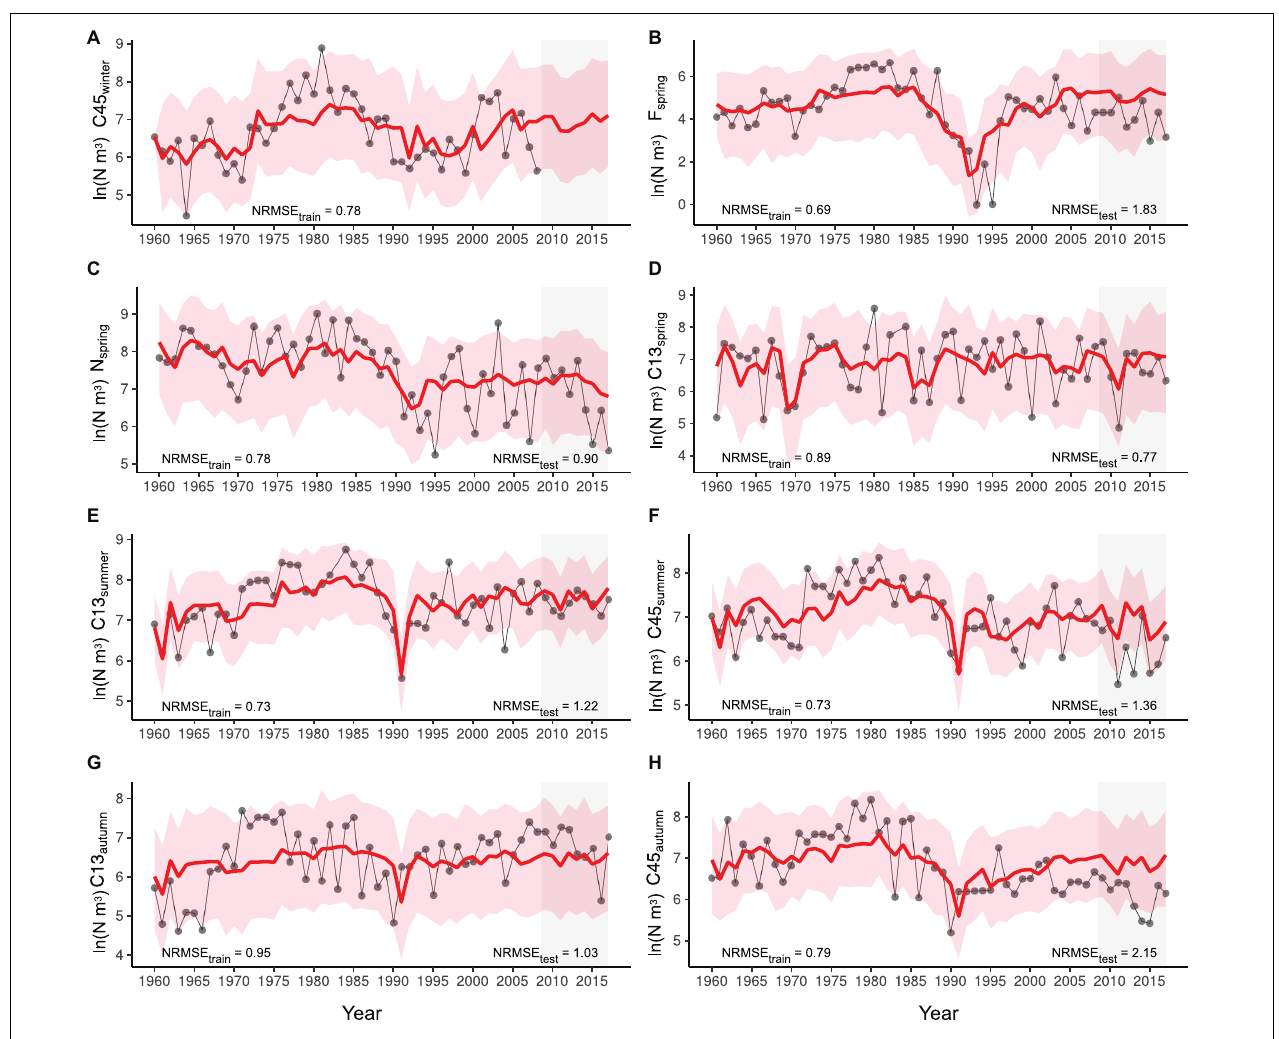
FIGURE 2 | Hindcast of seasonal stage abundances for the training and test (gray shaded box) period using our coupled life cycle model. Simulations were started using the first observation of C45 winter abundances of the series (in 1960) from which the female spring abundance and consecutively the various seasonal stage abundances within this and the following years were predicted (from A–H ). The red line represents the mean of the 1000 Monte Carlo simulations, the red shaded area the 95% confidence interval. The gray line with circles represents the observed time series. The normalized root mean square error (NRMSE) for both the training and test period is provided as measure of model